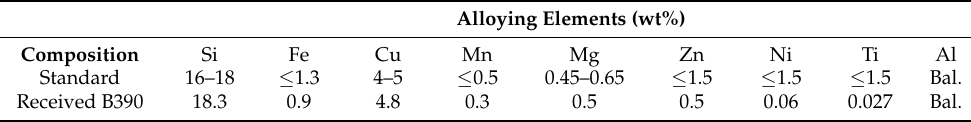
Table 1. Chemical composition of the specimen used in this study